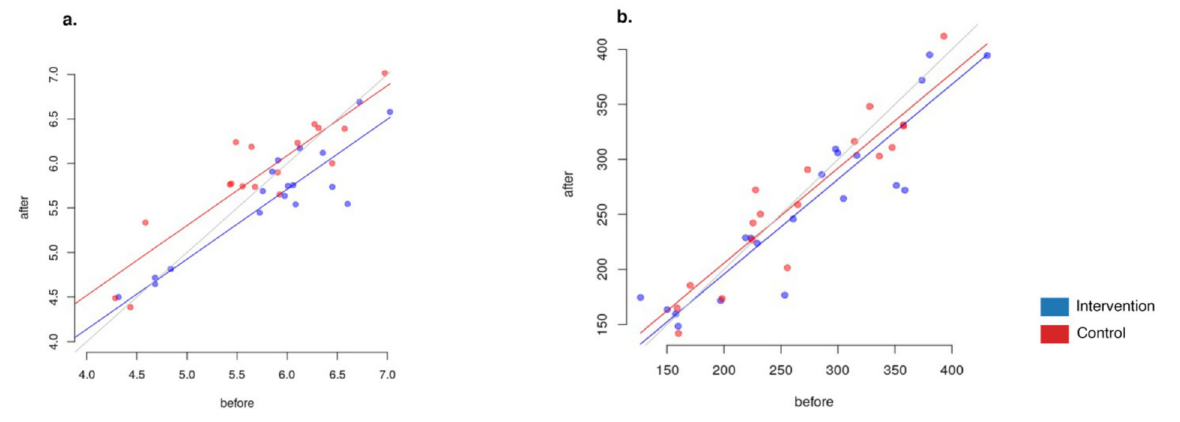
Figure 6. Alpha-diversity values before and after the intervention. ( a ) Shannon index ANCOVA ( p = 0.004). ( b ) Chao index ANCOVA ( p =